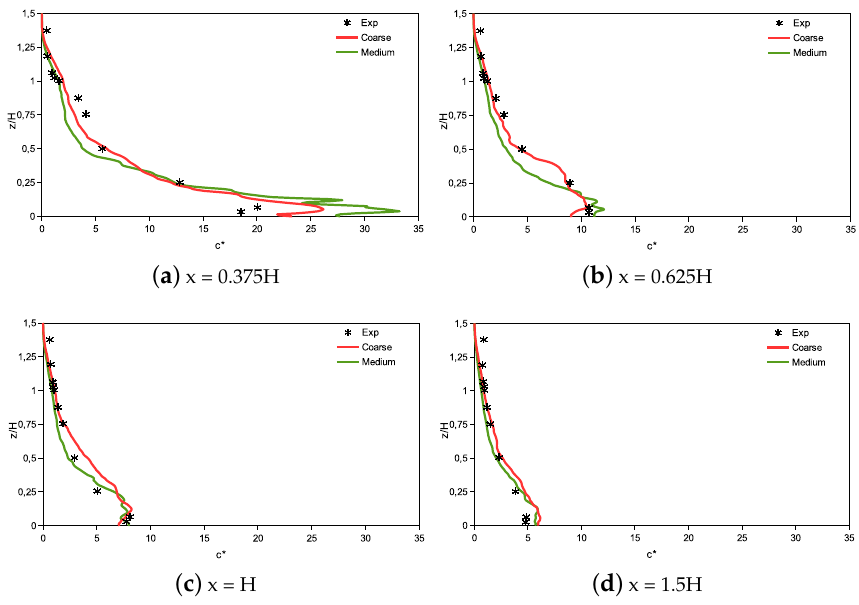
Figure 9. Comparisons of normalized pollutant concentrations at different positions downstream of the